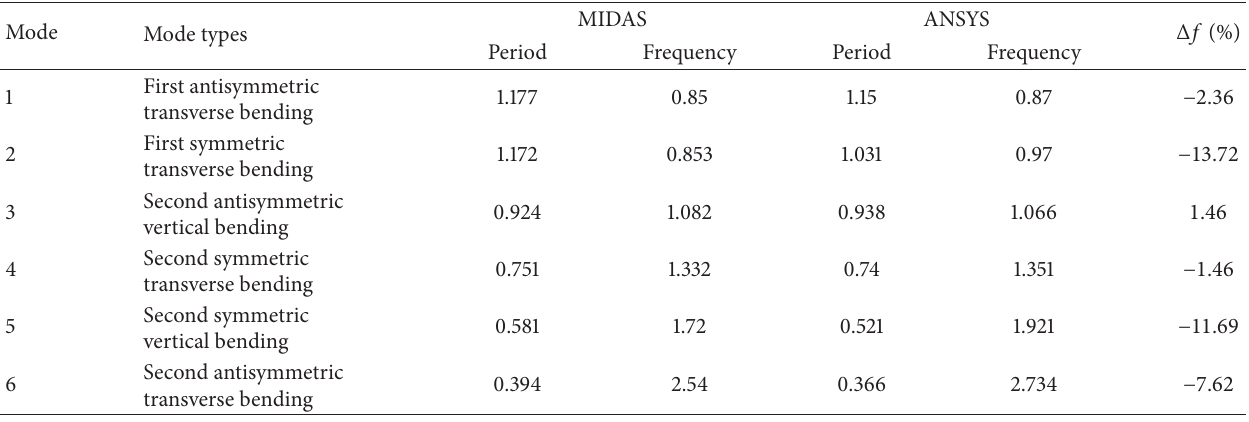
Table 3: Comparisons for natural frequencies and periods between ANSYS and MIDAS.